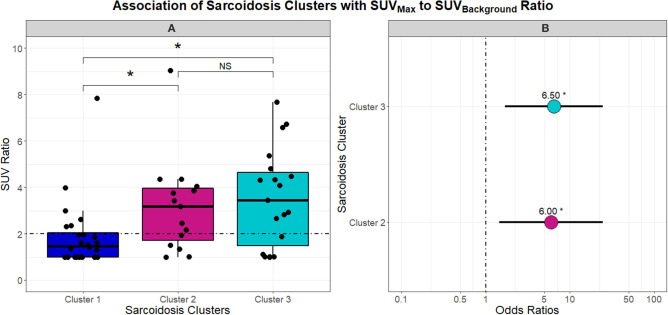
Box and whisker plots in (A) demonstrate the association between UIC-Sarcoidosis cohort clusters and the SUVBackground-to-SUVMax ratio (SUV ratio). An SUV ratio of 2 was pre-specified as a cutoff value to indicate increased inflammatory activity on 18FDG-PET/CT (PET-positivity) and is depicted in (A) as the dashed black horizontal line. A significant association between clusters and SUV ratio was found by Kruskal-Wallis test (p = 0.0052). Post-hoc analysis with Dunn's test demonstrated significantly elevated inflammatory activity, denoted with an asterisk (*), in Clusters 2 and 3 compared to Cluster 1 (BH-adjusted p = 0.0332 and 0.0136, respectively). No difference (NS) was observed between Cluster 2 and Cluster 3 with regards to inflammatory activity. To assess the probability of PET-positivity based on clusters, a logistic regression model was constructed and the dot plot in (B) highlights the odds ratios derived from the model. Cluster 1 was considered the reference given that it demonstrated significantly decreased 18FDG-PET/CT activity compared to the other two clusters. Ultimately, Cluster 2 and Cluster 3 were found to have a 6 and 6.5-fold greater risk of PET positivity (β = 1.7918 and 1.8718 and p = 0.0132 and 0.0061; respectively).